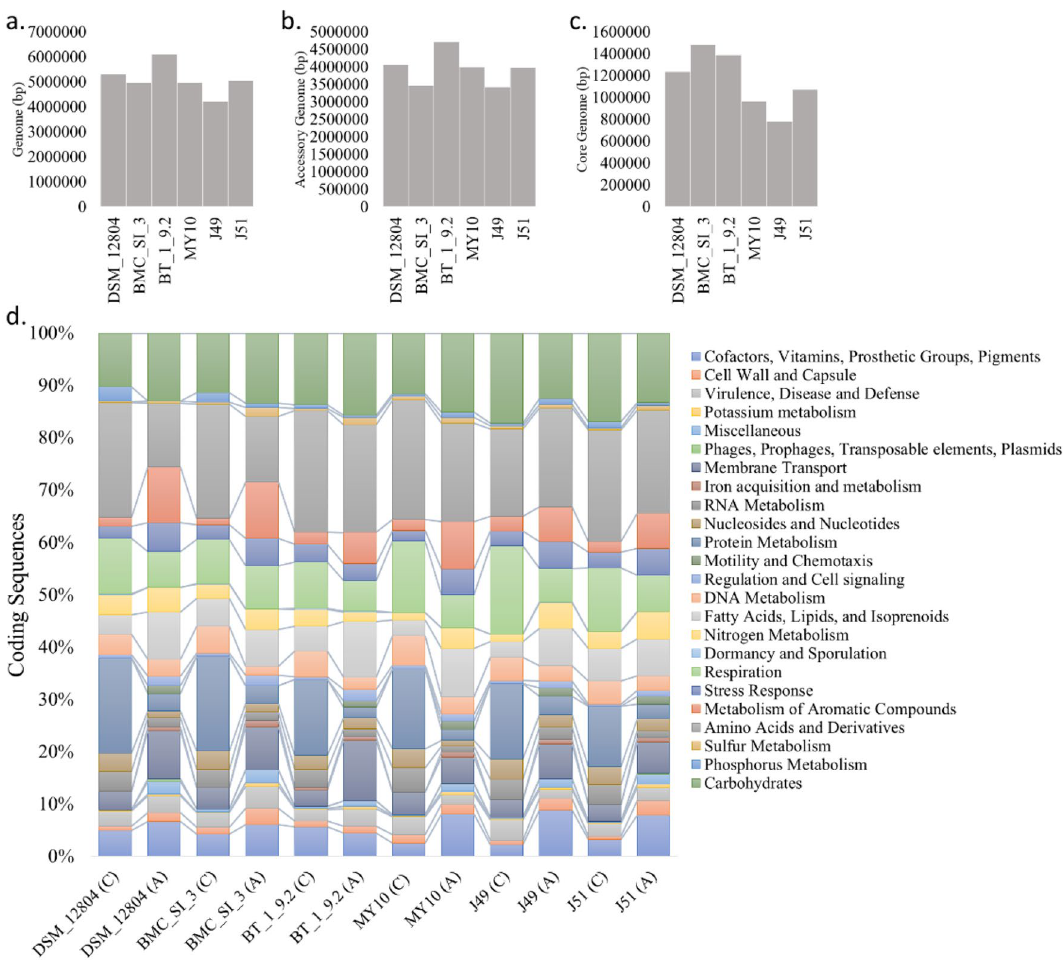
Figure 7. Pangenome analysis strains representing strain-specific genome size ( a ), accessory genome size ( b ), core genome size ( c ), and functional annotation of Bordetella petrii